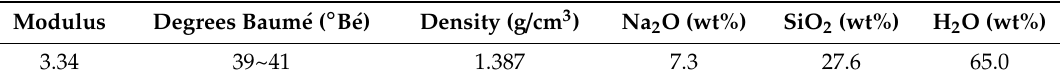
Table 5. Properties of Na 2 SiO 3 solution. (Reproduced from the previous work [46] with permission from